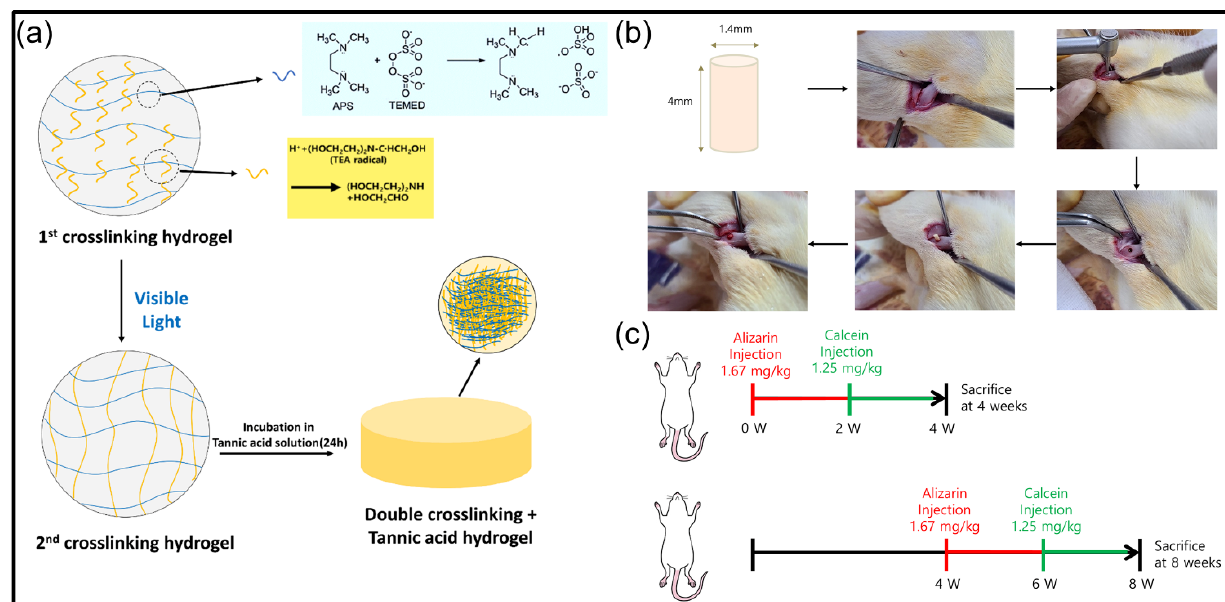
Figure 1. Schematic diagram of ( a ) Fabrication of double crosslinked hydrogel and tannic acid treatment, ( b ) Sample type and location for in vivo test (Sample placement in the femur), ( c ) Group division according to the schedule of staining reagent injection time for checking and analyzing bone formation behavior.